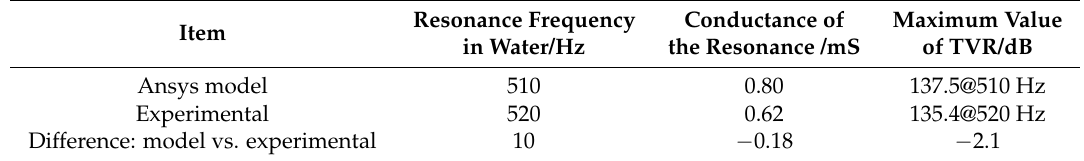
Figure 20. The transmitting voltage response curves of the transducer in water. Table 3. Comparisons of predicted values to those measured on the prototype.